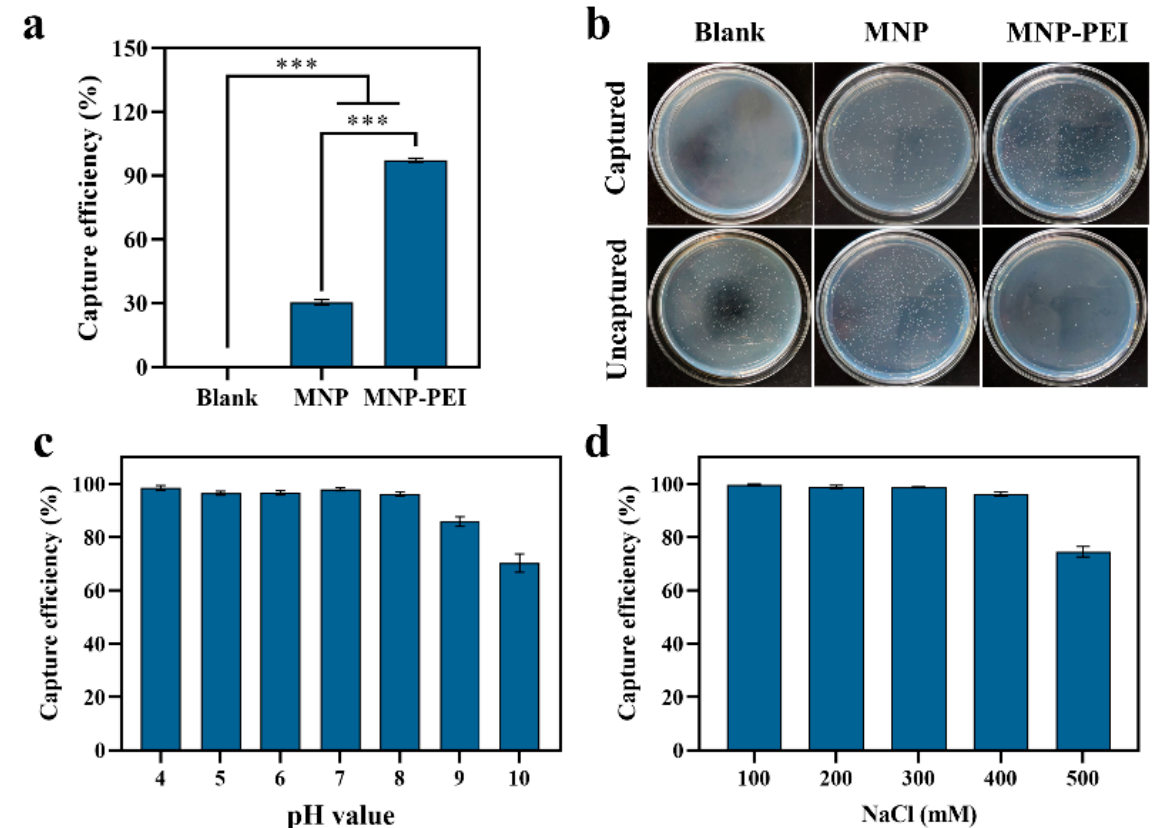
Figure 3. CE of L. monocytogenes under different conditions. ( a ) CE of L. monocytogenes captured by MNP and PEI-MNPs, ( b ) Images of L. monocytogenes colonies captured by MNP and PEI-MNPs on BHI agar. ( c ) Effects of pH on the CE by PEI-MNPs. ( d ) Effects of ionic strength on the CE by PEI-MNPs. *** represents p < 0.001.